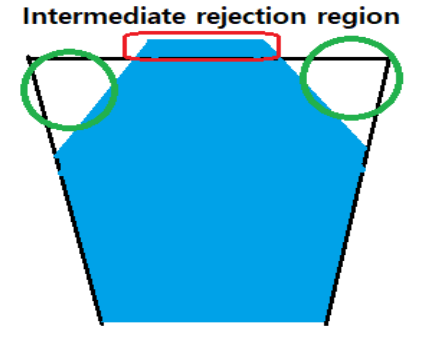
Figure 15. An example rejection region.